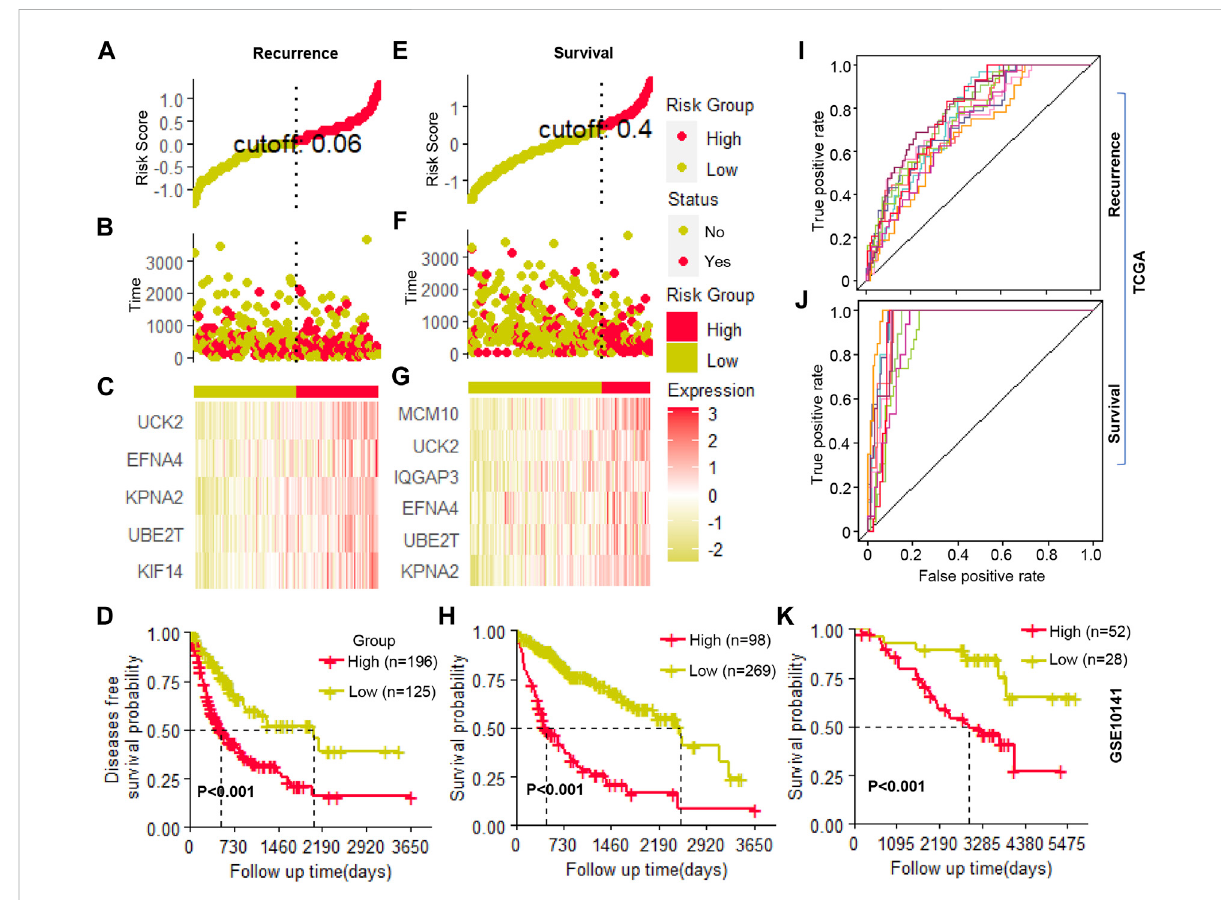
FIGURE 6 Coxregressionmodelconstruction (A – C) .Thecutoffvalueselection,patientstrati fi cation,andclonalgeneexpressionintherecurrencemodel (D) . The Kaplan-Meier (KM) curve of patients ’ recurrence-free survival (E – G) . The cutoff value selection, patient strati fi cation, and clonal gene expression in the survival model (H) . The Kaplan-Meier (KM) curve of patients ’ overall survival (I,J) . The ROC curve of ten random repetitions in recurrence and survival models (K) . The Kaplan-Meier (KM) curve of patients ’ overall survival in an independent